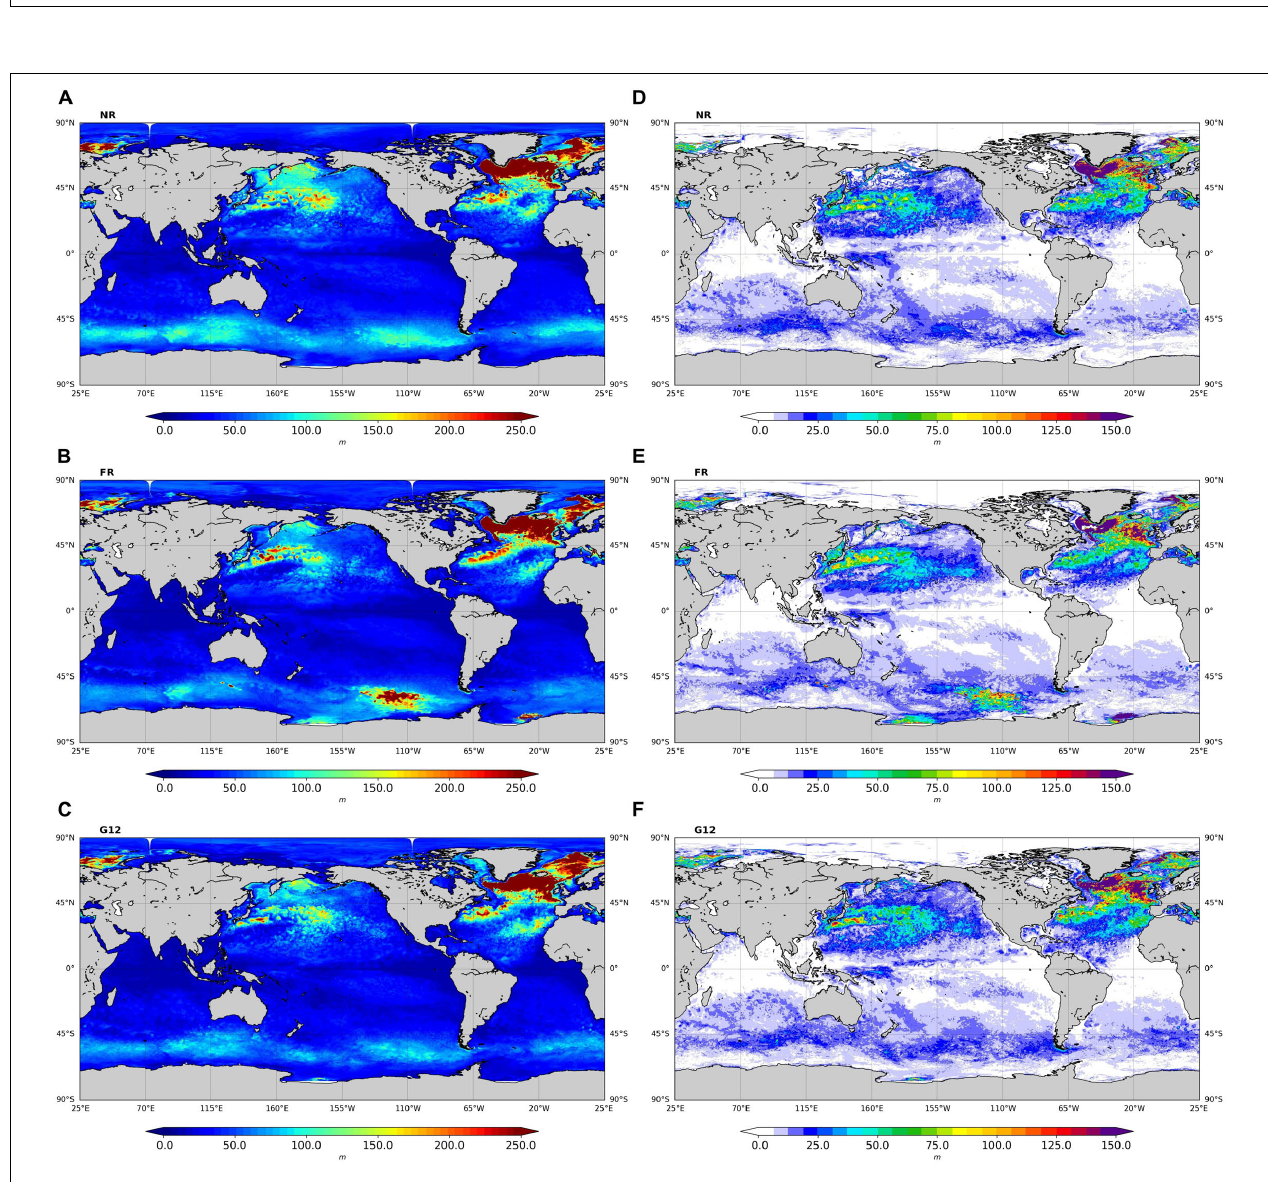
FIGURE 4 | Mean and Standard deviation of the mixed layer depth (MLD, m, March 2015); Mean: NR (A) , FR (B) , and G12 (C) . Standard deviation: NR (D) , FR (E) , and G12 (F) .